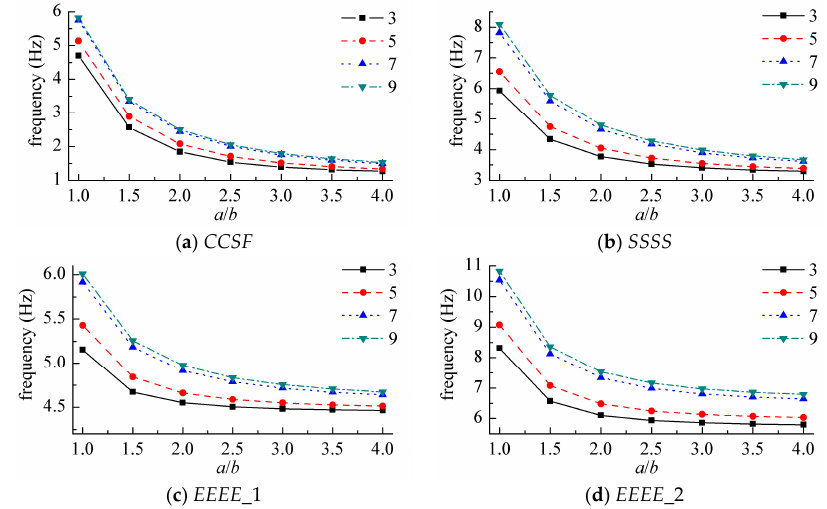
Figure 10. Natural frequency parameters for symmetric angle-ply laminates. ( a ) CCSF, ( b ) SSSS, ( c ) EEEE _1, ( d ) EEEE _2.